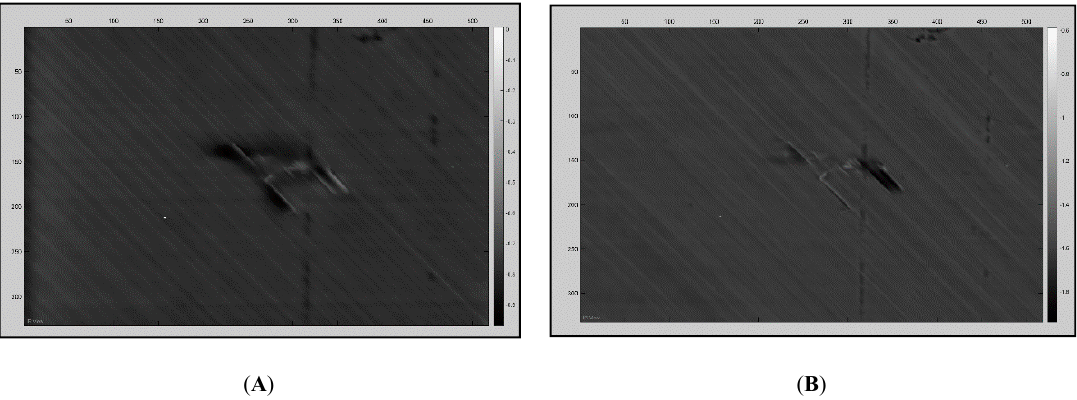
Figure 10. ( A ) Fourier transform phase; the damage shown is the subsurface. ( B ) Fourier transform phase; the damage visible is closer to the surface.